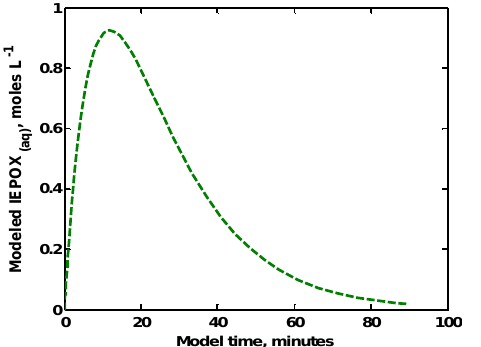
Figure 2. Model output of aqueous-phase IEPOX concentrations during Exp. no. 1 simulation.